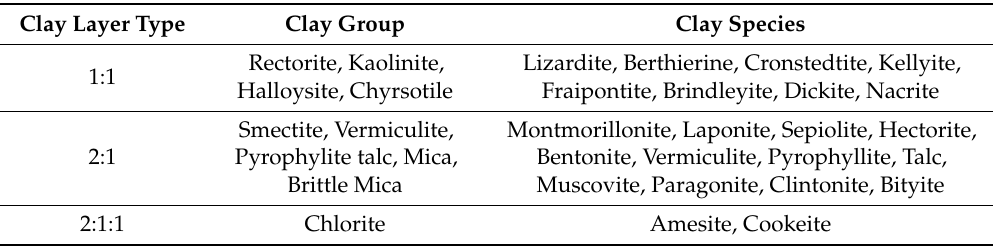
Figure 1. Crystal structures of clay minerals: ( a ) Type 1:1; ( b ) Type 2:1 [49]. Table 1. Classification of clay minerals.